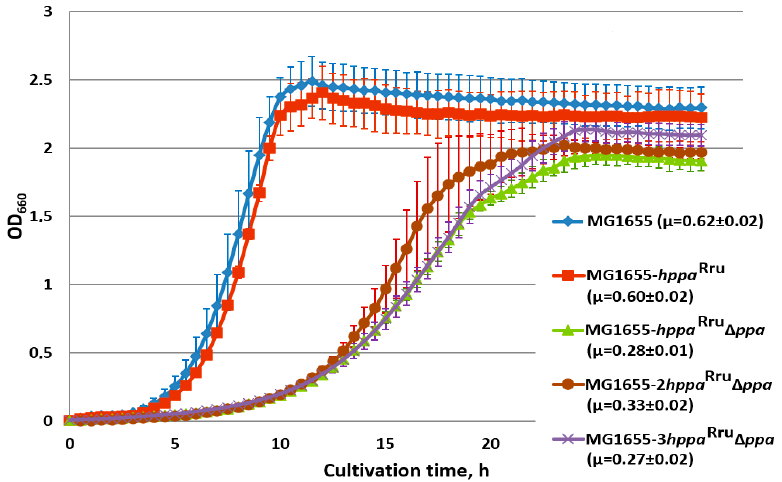
Figure 4. Growth of strains, harboring 1, 2, or 3 copies of the hppa Rru gene in the presence and absence of E. coli ppa . Cells were grown with aeration in L-tubes with M9 minimal medium supplemented with 0.3% of glucose at 37 o C in an Advantec photorecorder. MG1655, MG1655 wild-type; MG1655- hppa Rru , MG1655 IS 5.8::P L - hppa Rru ; MG1655- hppa Rru ∆ ppa , MG1655 IS 5.8::P L - hppa Rru ∆ ppa ; MG1655-2 hppa Rru ∆ ppa , MG1655 IS 5.8::P Rru adrA ::P Rru ∆ ppa ; MG1655-3 hppa ∆ ppa L - hppa L - hppa